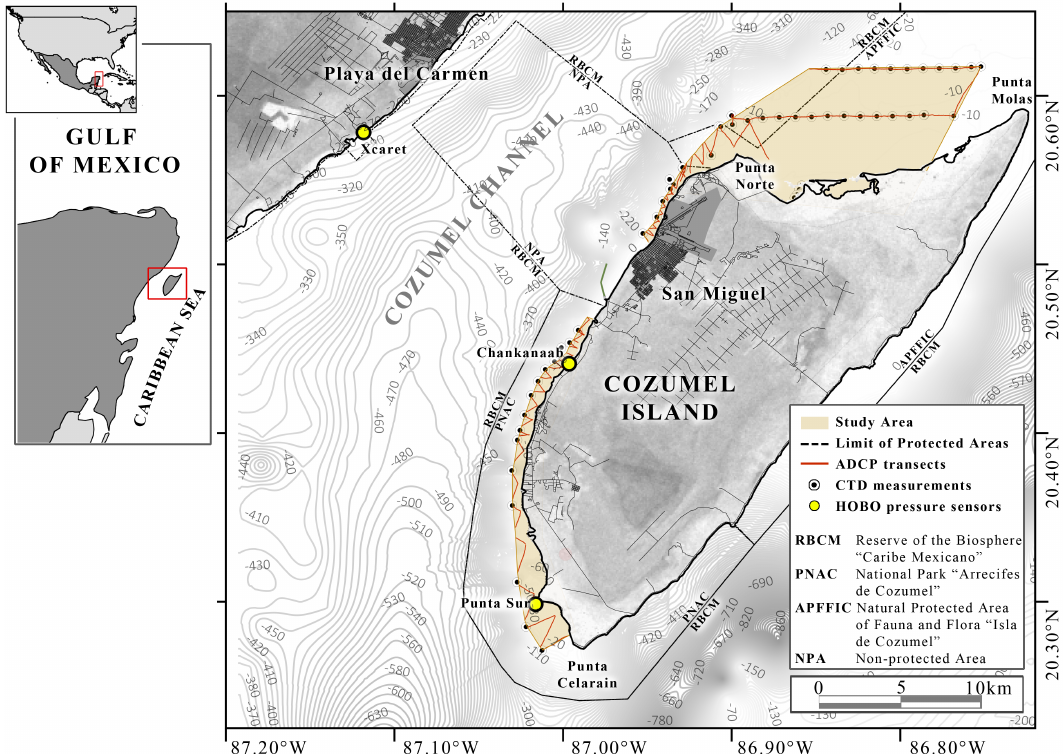
Figure 1. Map showing the location of the Cozumel Channel, marine protected areas, bathymetry and human settlements of Playa del Carmen and San Miguel ( right ). The locations of ADCP, CTD profile measurements along the study area as well as deployments of HOBO water level data loggers at Chankanaab (20.44111° N, 86.99639° W), Punta Sur (20.29853° N, 87.01632° W), and Xcaret (20.57826° N, 87.11834° W) are also